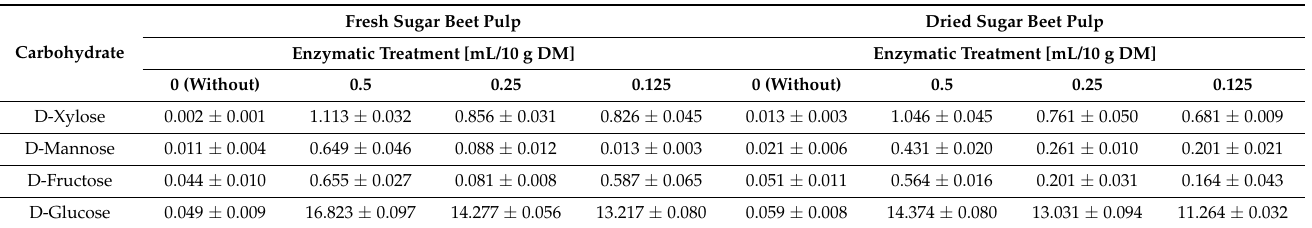
Table 1. Sugar profiles in tested waste biomass before and after enzymatic hydrolysis [g/L] with various enzyme concentrations.